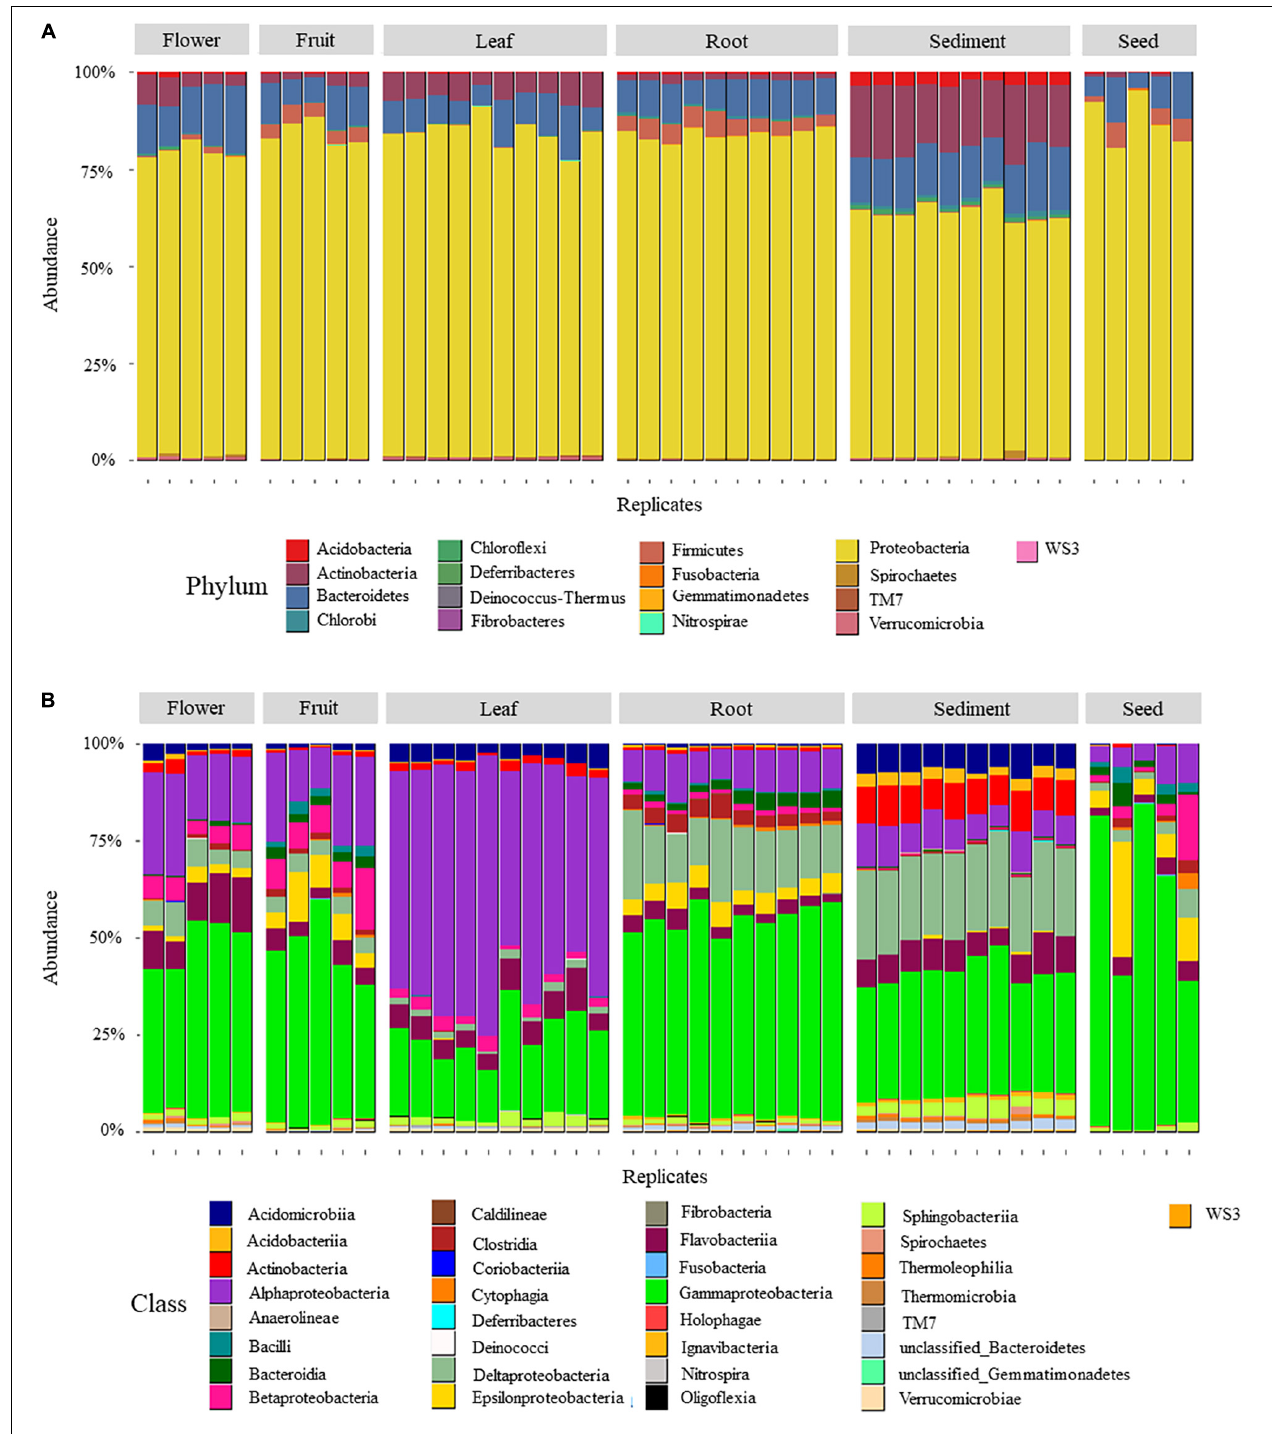
FIGURE 1 | Relative abundance of OTUs aggregated by phylum (A) and class (B) in six H. ovalis microenvironments (rhizospheric sediment, roots, leaves, flowers, fruits, and seed). Numbers are presented in percentage.